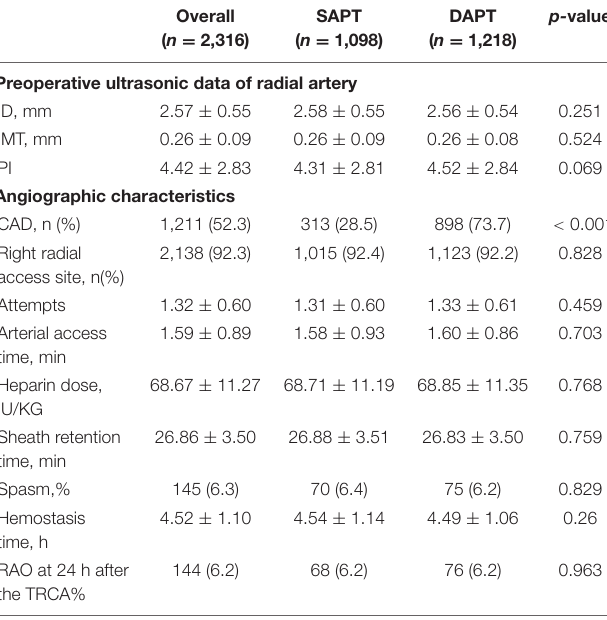
TABLE 2 | Preoperative ultrasonic data of radial artery and angiographic